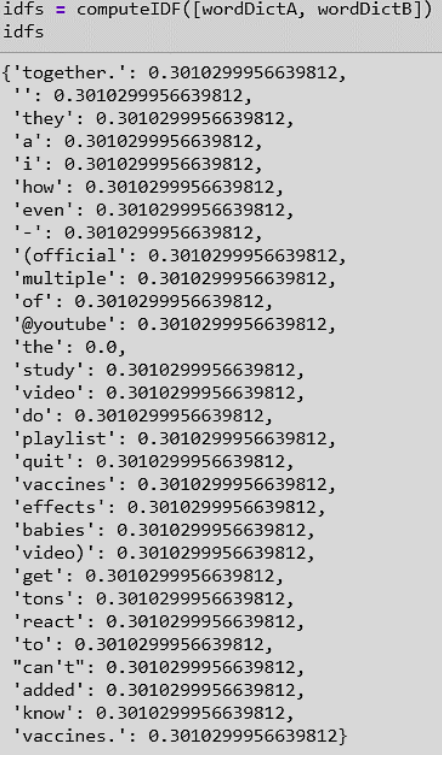
Figure 13. Example of inverse data frequency ( IDF) scores in Document 1 and 2 of the data set.